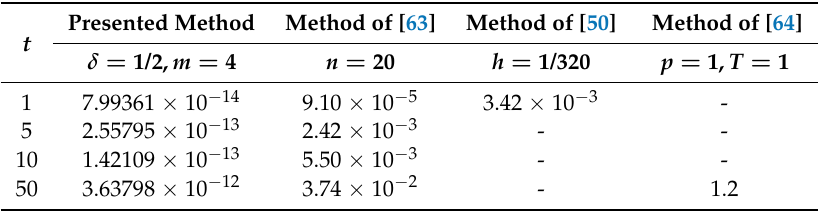
Table 7. Comparison of absolute errors between proposed method and some other numerical methods in literature at t = 1,5,10,50 for α =